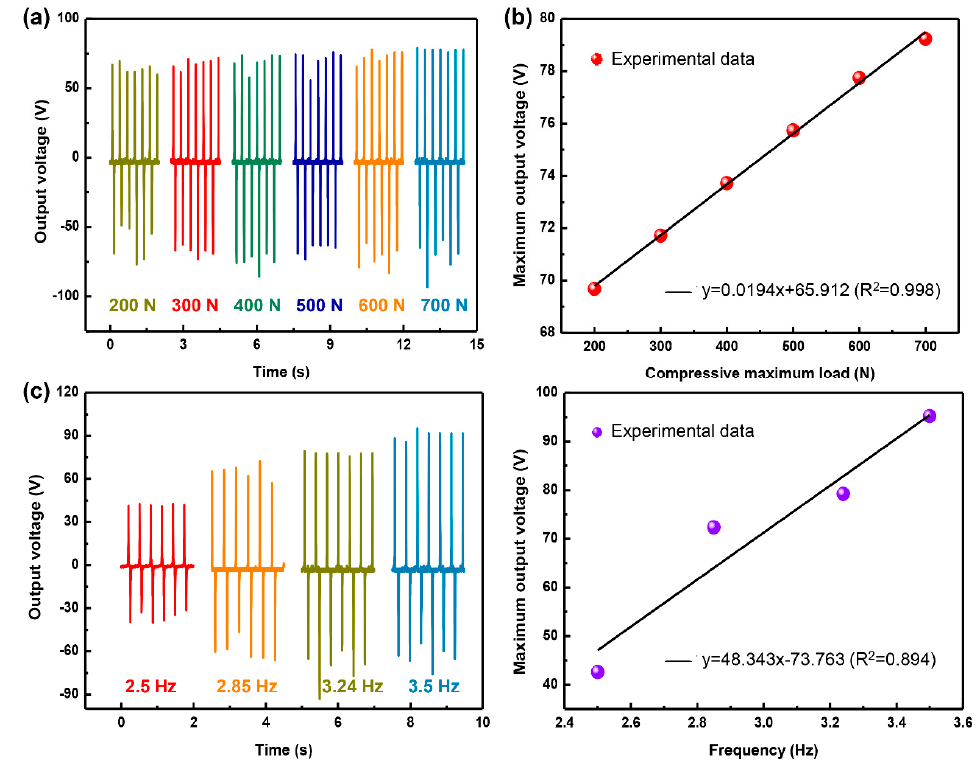
Figure 8. ( a ) Output voltage vs. time curves under various compressive loads. ( b ) Fitting curve of maximum output voltage as a function of compressive load. ( c ) Output voltage vs. time curves under various frequencies. ( d ) Fitting curve of maximum output voltage as a function of frequency.